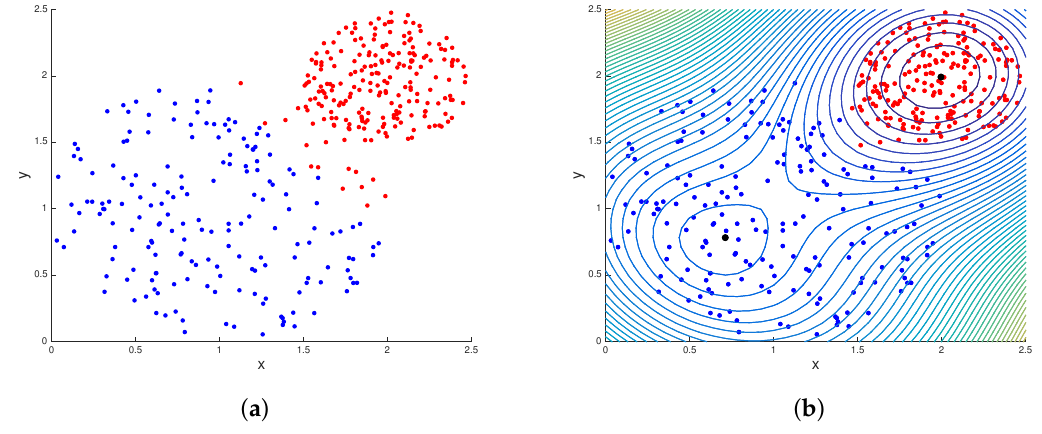
Figure 2. K-means vs. quantum clustering on two overlapping circles. ( a ) K-means clustering: the smaller circle “overflows” into larger blue circle; ( b ) quantum clustering: the contour plot better isolates the smaller circle, σ = 0.7125.